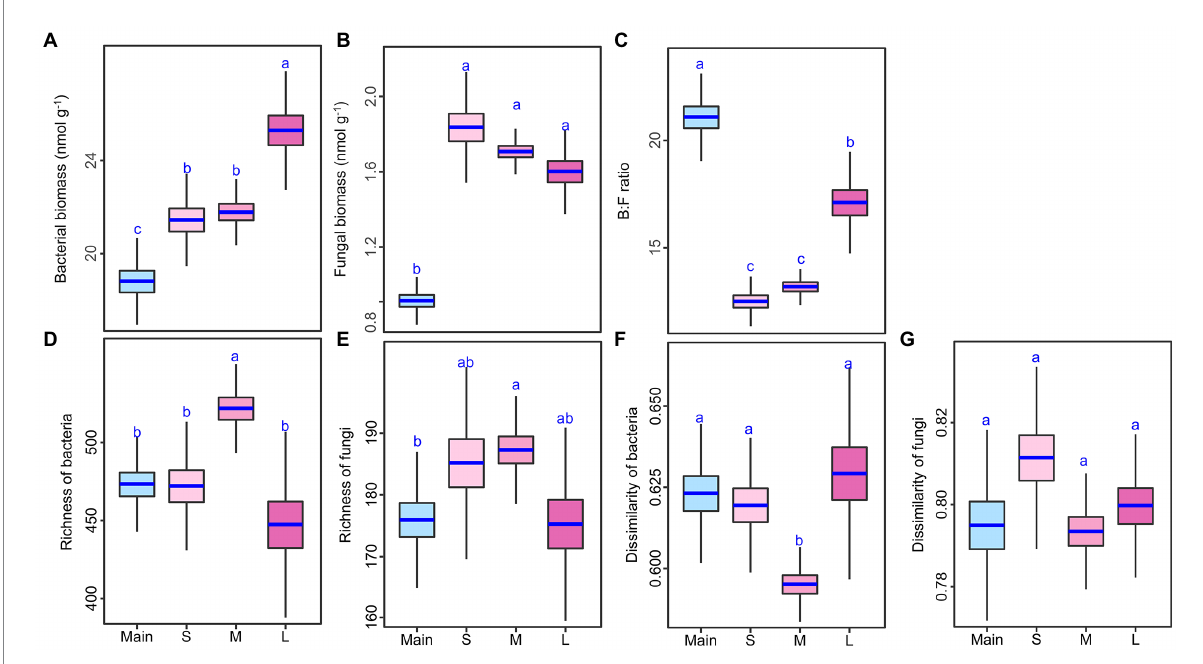
FIGURE 2 Differences in soil bacterial and fungal biomass, amplicon sequencing variant (ASV) richness, and dissimilarity (A–G) among the mainland (Main) and three island types (S: small islands; M: medium islands; L: large islands). Boxplots indicate the medians and upper and lower quartile of the posterior distribution. Different letters indicate a credibly different posterior distribution among the mainland and three island types (Bayesian- ANOVA, 95% highest density intervals of the posterior difference between each two groups falls above or below